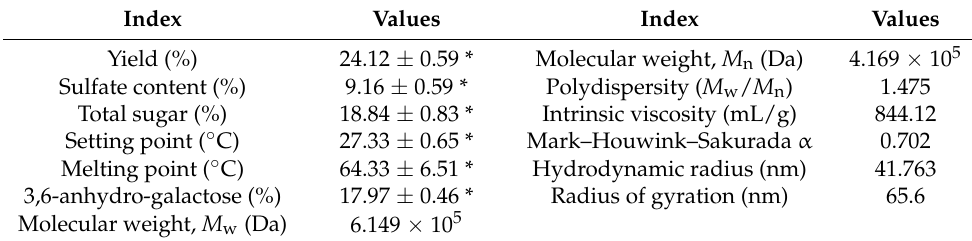
Table 1. Physical and chemical characteristics of G. blodgettii